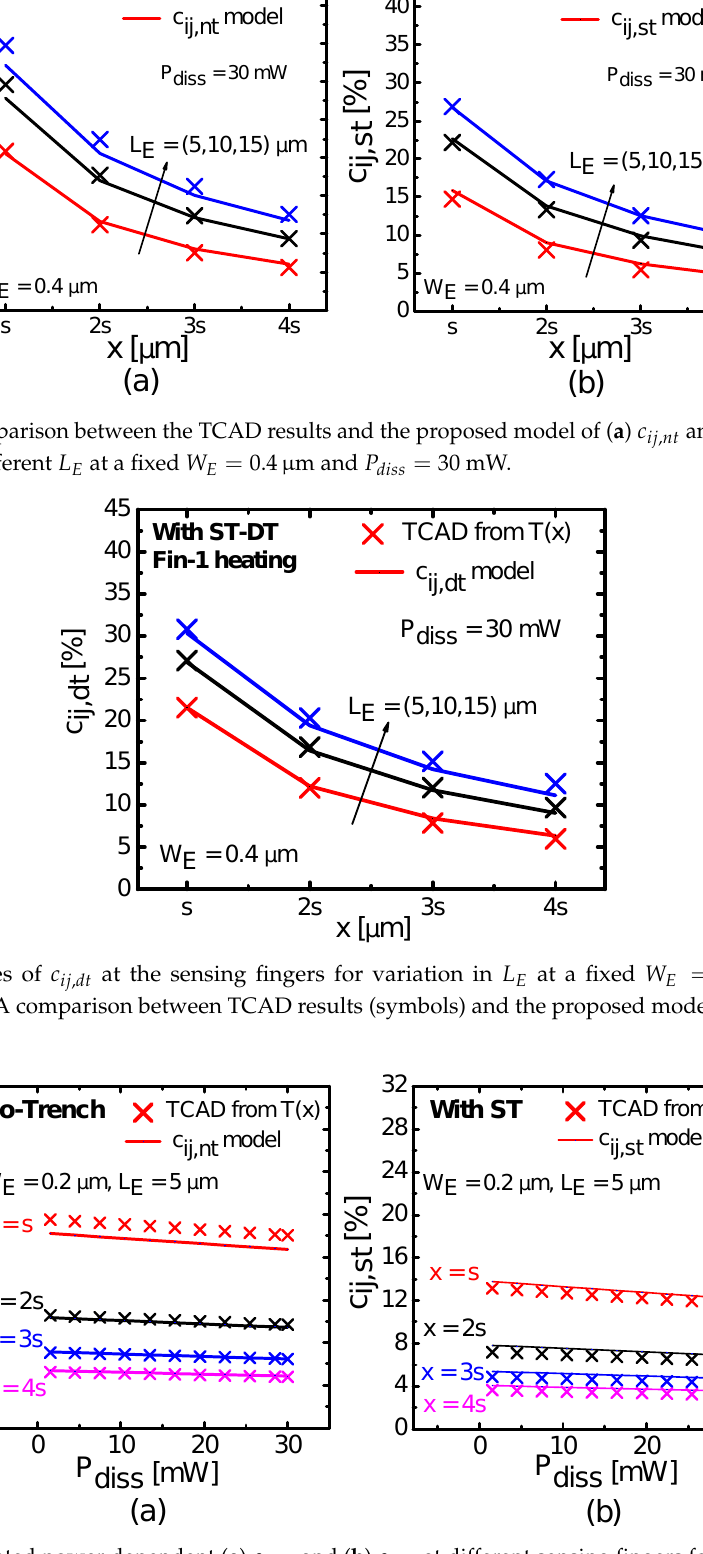
Figure 6. Dissipated power dependent ( a ) c ij , nt and ( b ) c ij , st at different sensing fingers for a structures with A E = 0.2 × 5 µ m 2 : A comparison between the proposed model and TCAD simulation